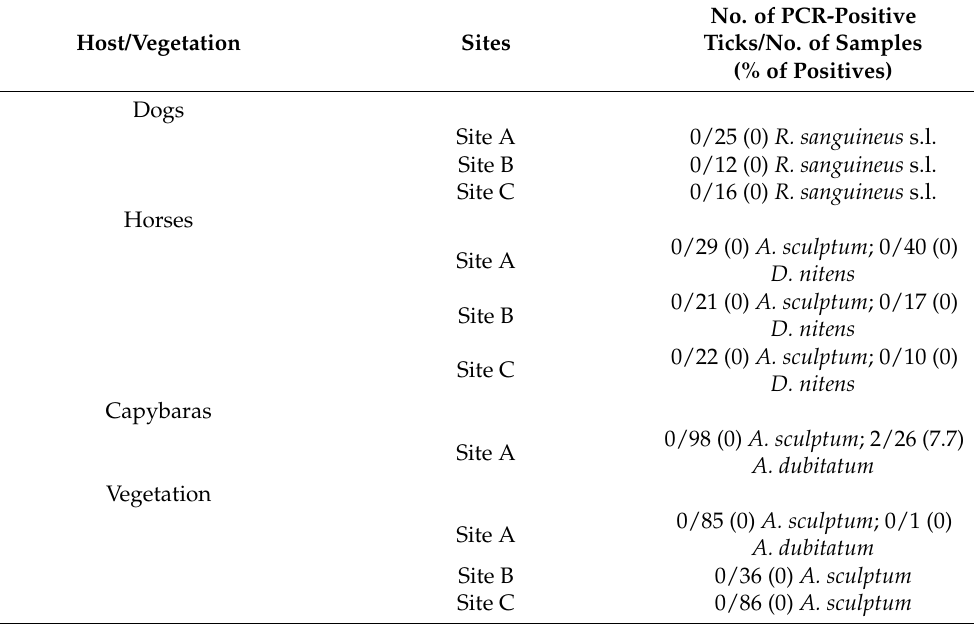
Table 3. Number and species of PCR-positive ticks collected from animals and vegetation in the city of Goi â nia, state of Goi á s, Brazil, between March 2020 and April 2022. Host/Vegetation Sites Dogs Horses Capybaras Vegetation